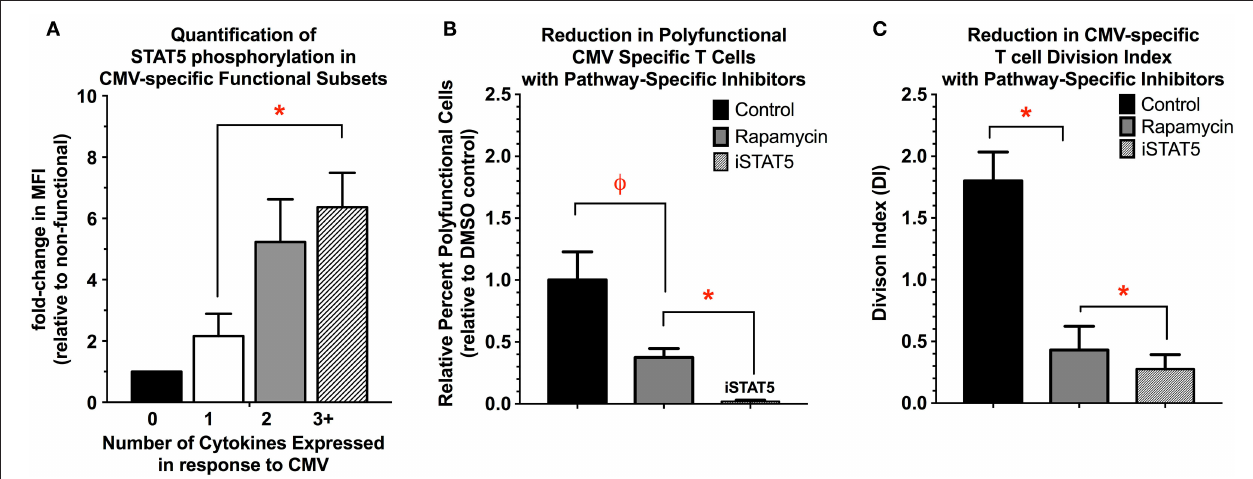
FIGURE 5 | (A) Quantification of STAT5 activity in functional subsets of CMV-specific T cells. STAT5 activity was determined by quantifying STAT5 phosphorylation in the functional subsets of CMV-specific T cells, and is expressed as the MFI relative to the non-functional subset ( n = 4). (B,C) Reduction in polyfunctional cell cytokine expression (B) and proliferation (C) with the use of pathway-specific inhibitors Rapamycin (200nM) and STAT5 inhibitor (CAS 285986-31-4, 200 µ M) ( n = 4). For cytokine expression, the data are presented as the percent-change in number of polyfunctional T cells relative to DMSO control (0.1% v/v). For proliferation, the data are presented as the division index (DI) for all remaining CMV-reactive T cells (i.e., expressing any type 1 cytokine), as the use of STAT5 inhibitor completely abolished the ability to detect polyfunctional T cells ( n = 4). Statistical testing: φ p < 0.005; * p < 0.05.